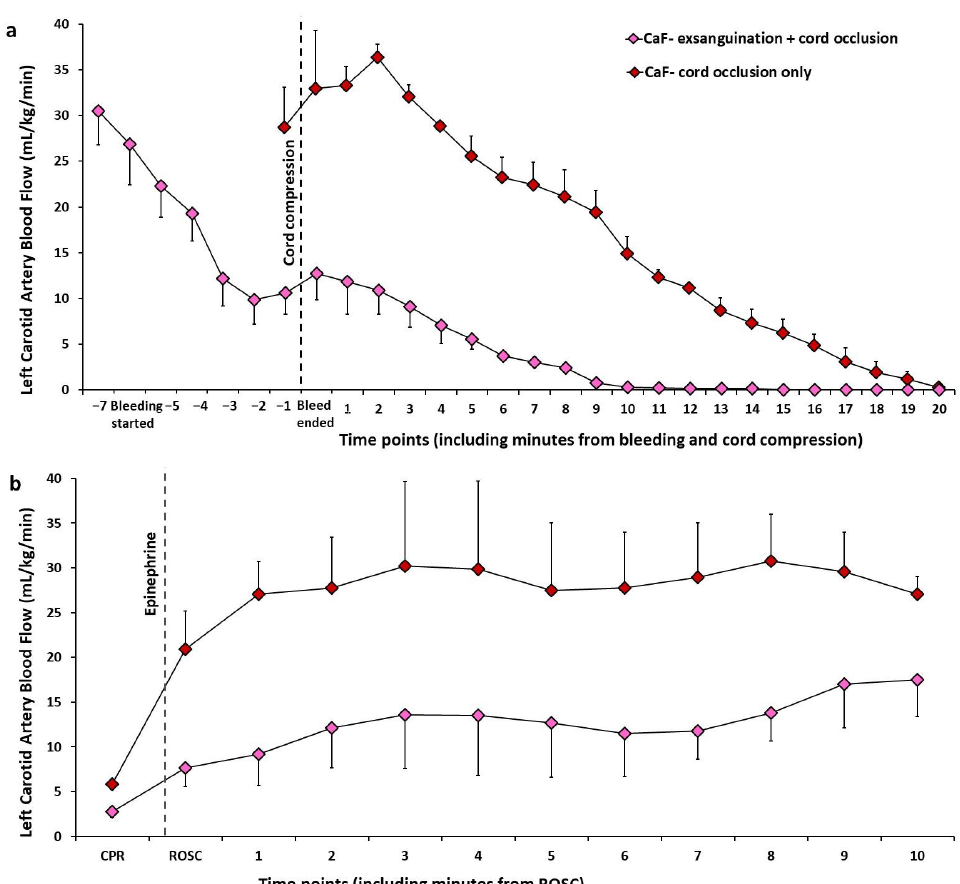
Figure 4. Changes in left carotid artery blood flow (CaF, mL/kg/min) during exsanguination fol- lowed by cord occlusion and during asphyxia by cord occlusion alone. The CaF decreases quickly and drastically during exsanguination in hypovolemic cardiac arrest ( a ). Following return of spontaneous circulation (ROSC), there is slower recovery of CaF in hypovolemic cardiac arrest when compared to normovolemic cardiac arrest ( b ). Copyright Deepika Sankaran.